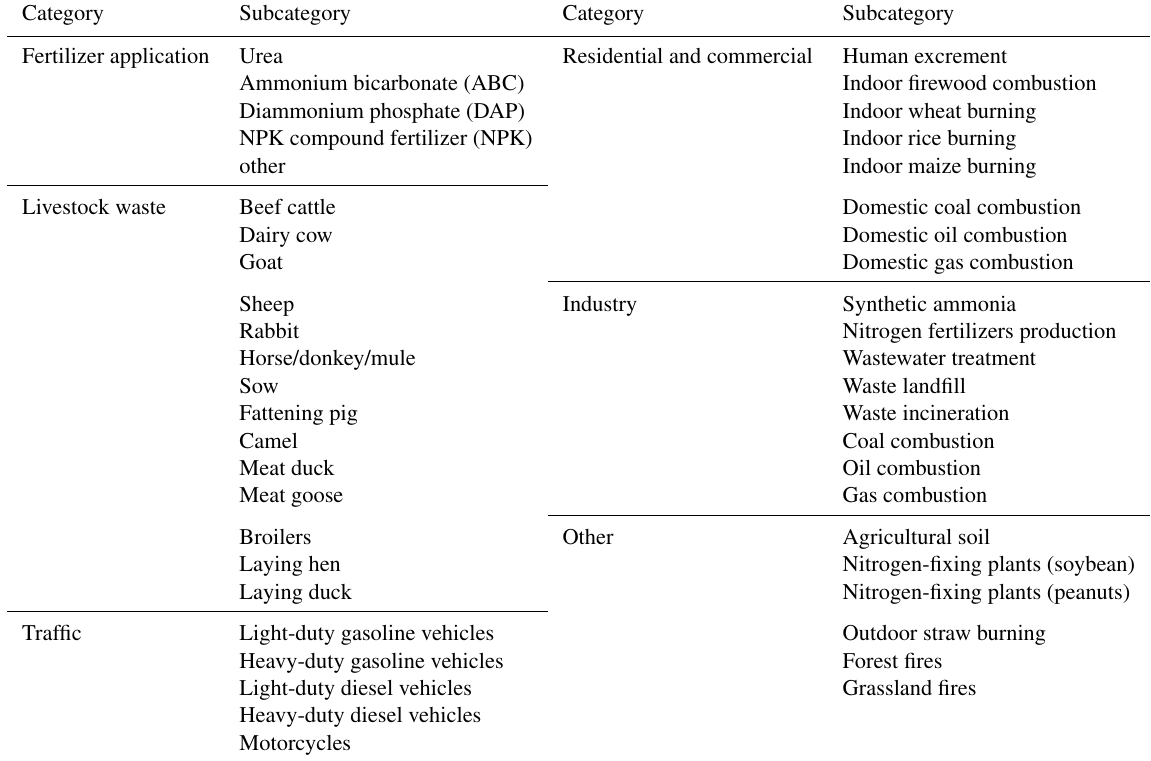
Table 1. NH 3 emission sources in